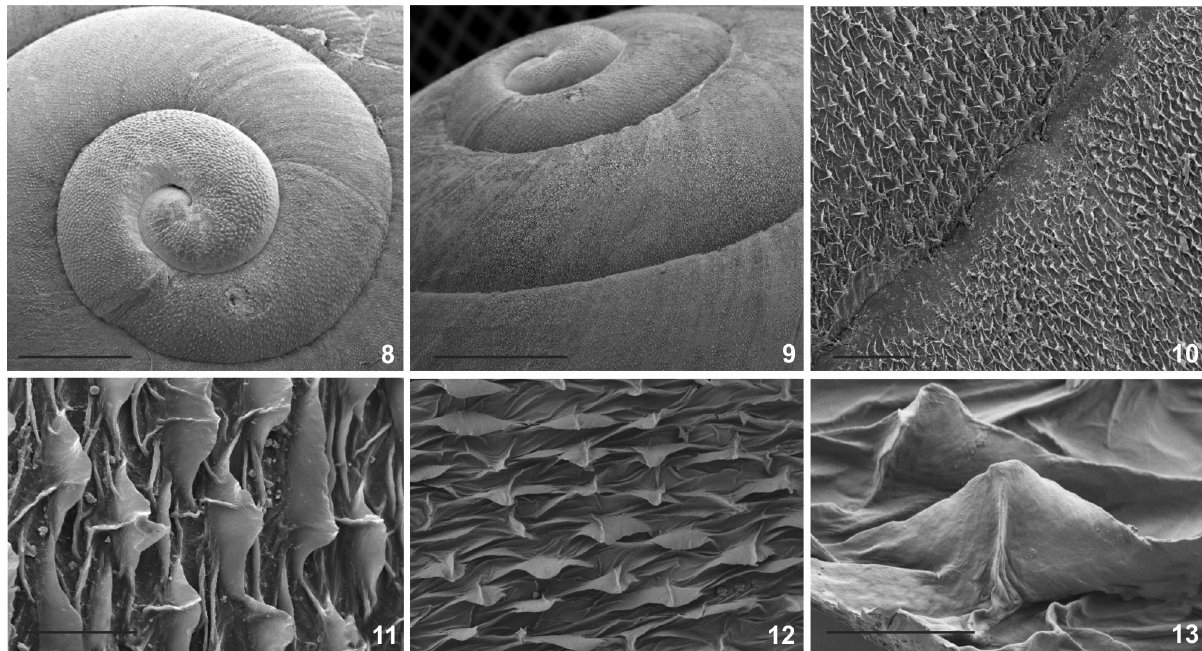
Figures 8–13. Shell morphology: (8) Protoconch in dorsal view, scale bar = 4mm; (9) lateral view of the protoconch and first whorls, scale bar = 4mm; (10) general view of the teleoconch microsculpture, scale bar = 100μ; (11) body whorl microsculpture consisting on axial rows of triangular lamella separated by wrinkles; (12) perpendicular view of the lamella, scale bar = 5μ; (13) detail of a triangular lamellae showing its central axis, scale bar = 2 μm.